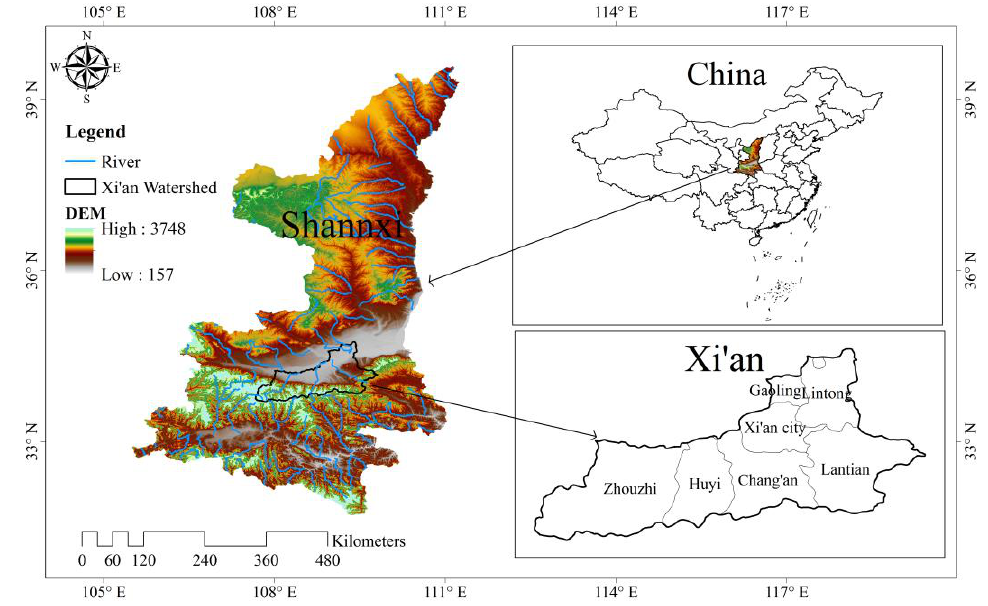
Figure 1. Location and administrative divisions of the study area.